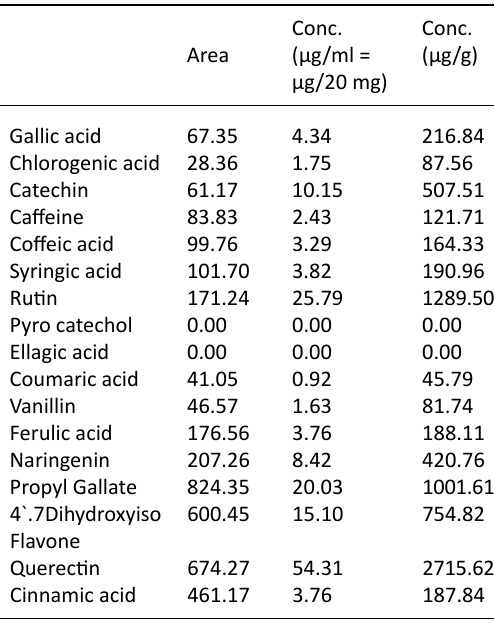
the highest concentration is Querectin (211.14 Conc. (µg / ml = µg / 15 mg) while the lower one Table 5. and figure3 show the Commiphora Table 3. Commiphora myrrh resin ethanol extract